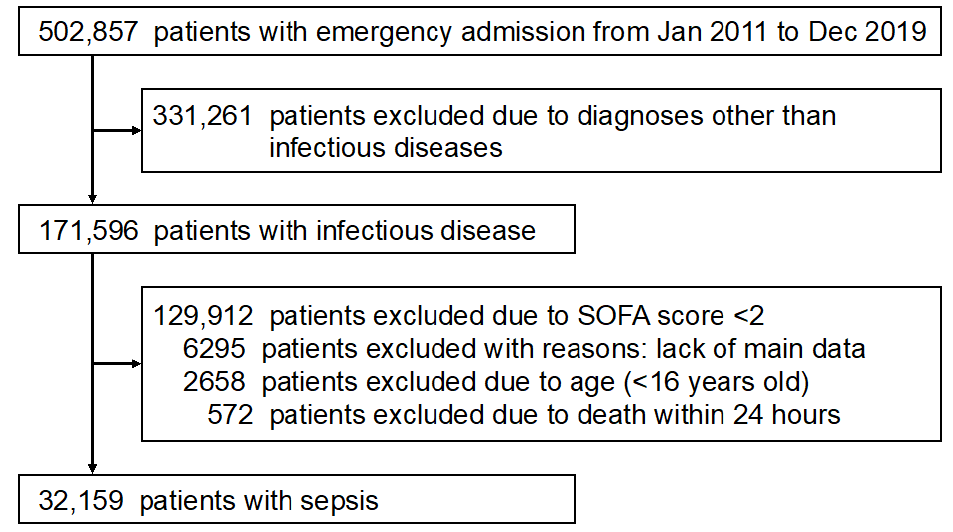
Figure 1. Patient flow diagram. SOFA, Sequential Organ Failure Assessment. Table 2. Patient